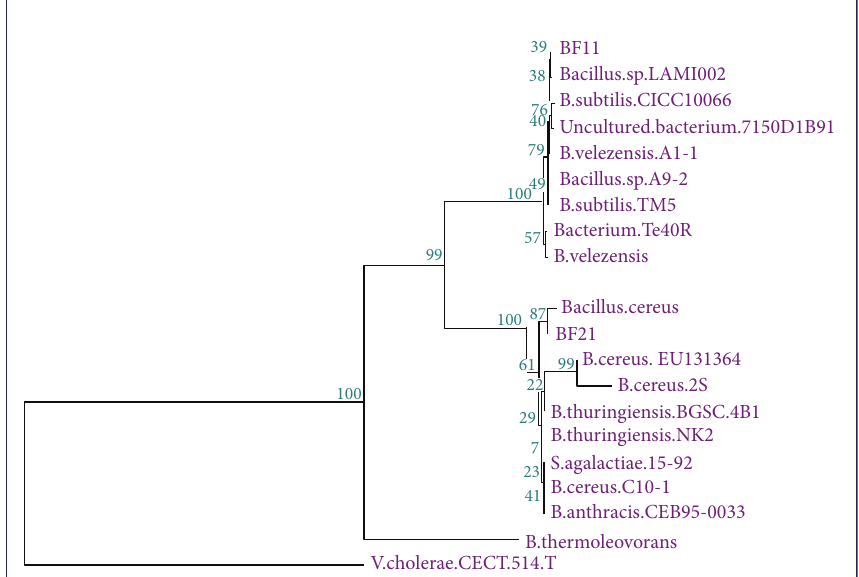
Figure 1: Phylogenetic analysis of 16S rRNA gene sequence of BF isolates.